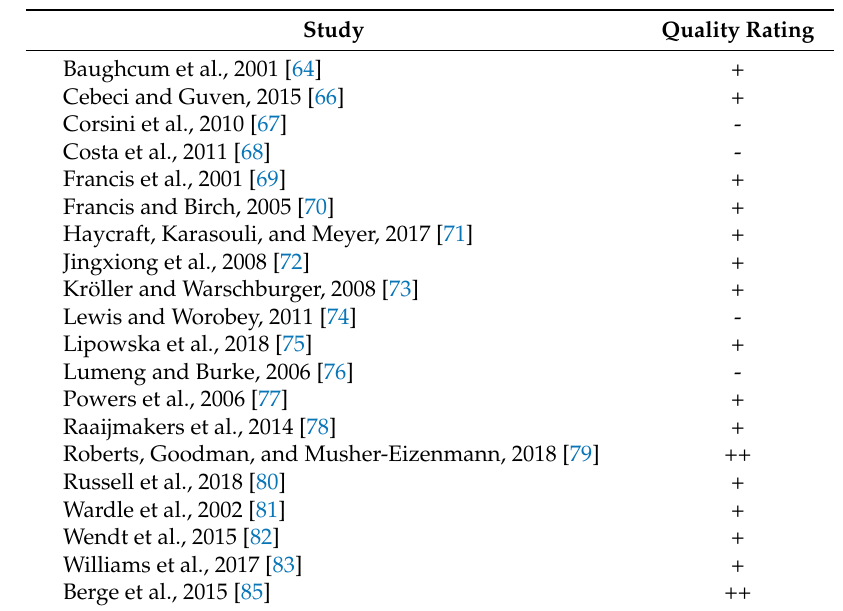
Table 1. Quality rating by